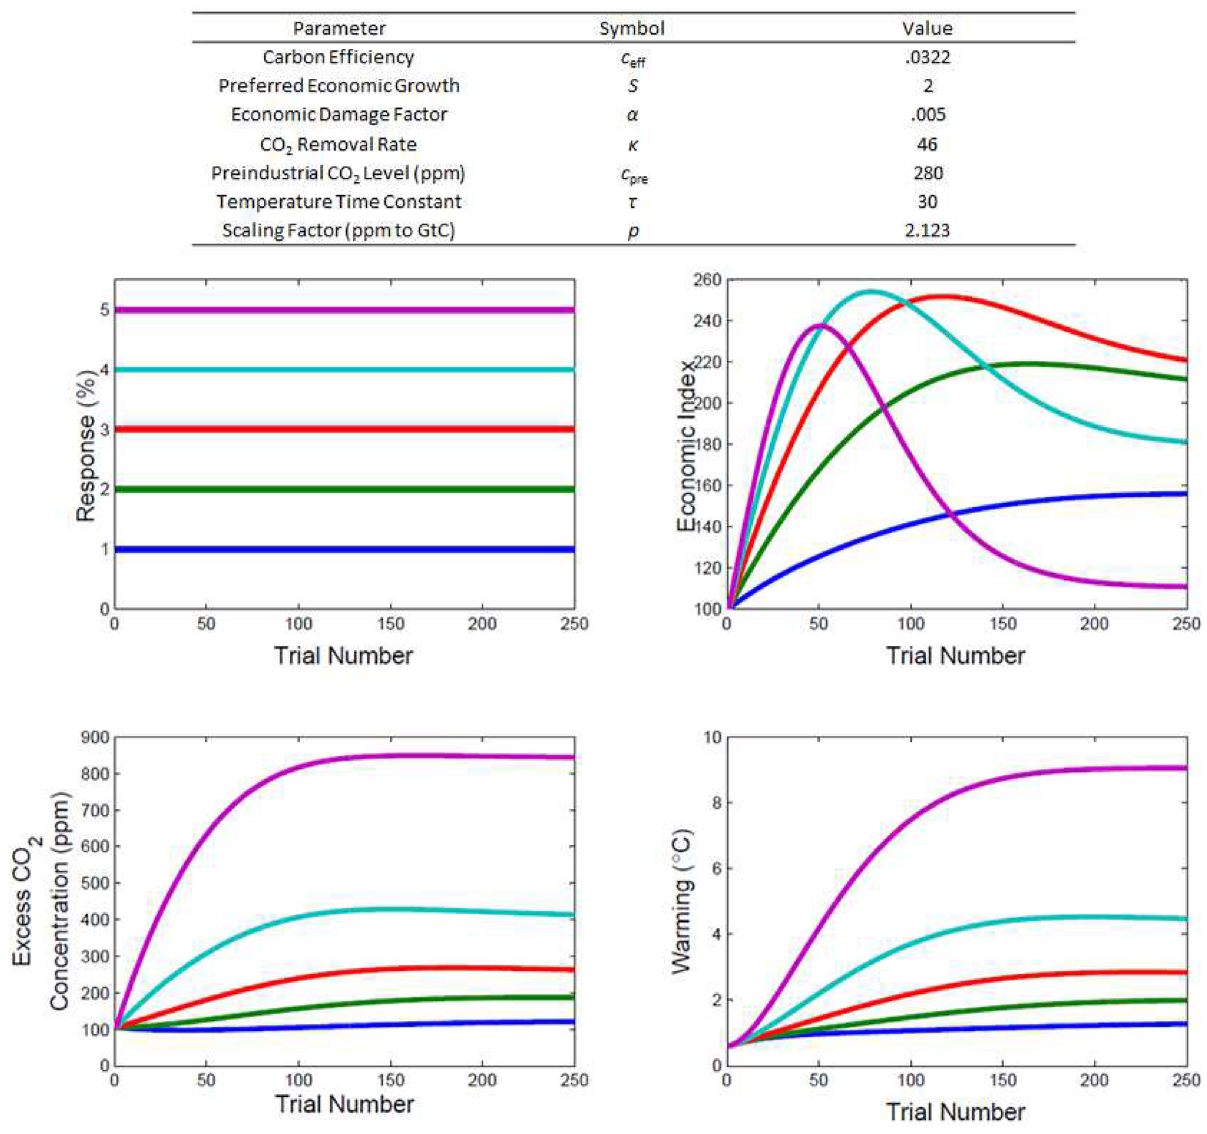
Fig 2. Illustration of the human-climate model dynamics for five different levels of responding. Economicproductivity targets of 1, 2, 3, 4, and 5 percent are shown by the blue, green, red, cyan, and purplesolid lines, respectively.Parameters governing the behaviorof the model are shown abovethe